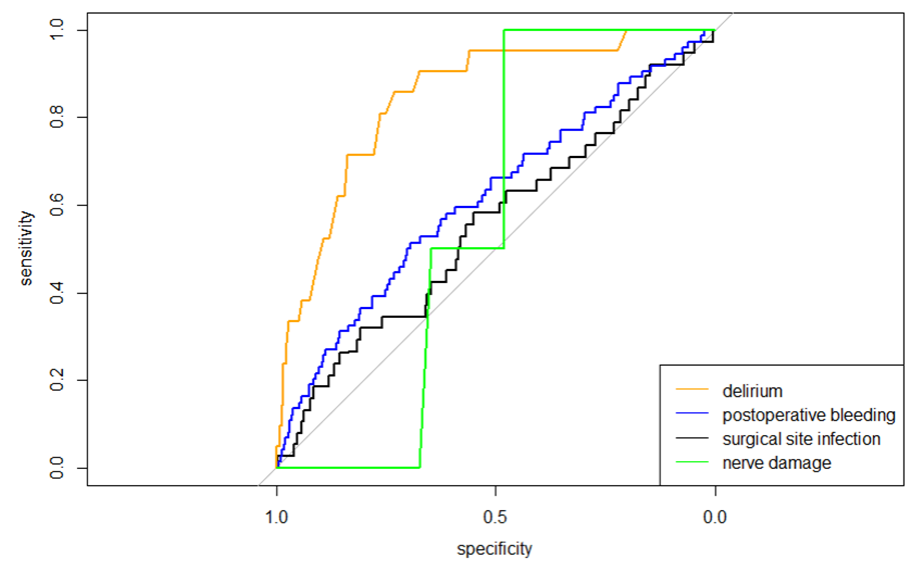
Figure 1. ROC curves of all four models predicting surgical complications, indicating the discrimina- tive performance of all models concerning the probability of a surgical complication. Table 2. Discriminative (AUC) and predictive (H-L) performance per model.